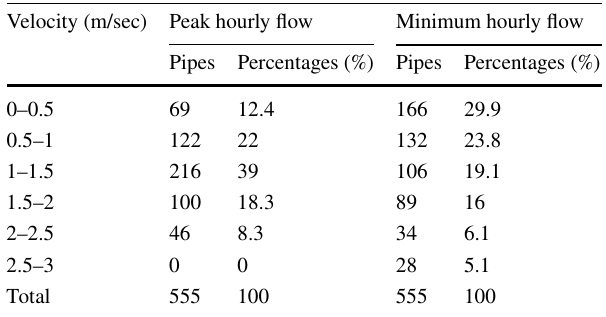
Table 9 Actual velocity of distribution system during peak hourly and minimum hourly flow Velocity (m/sec) Peak hourly